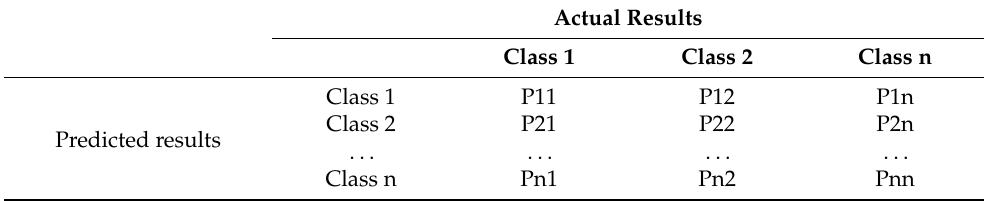
Table 2. Confusion